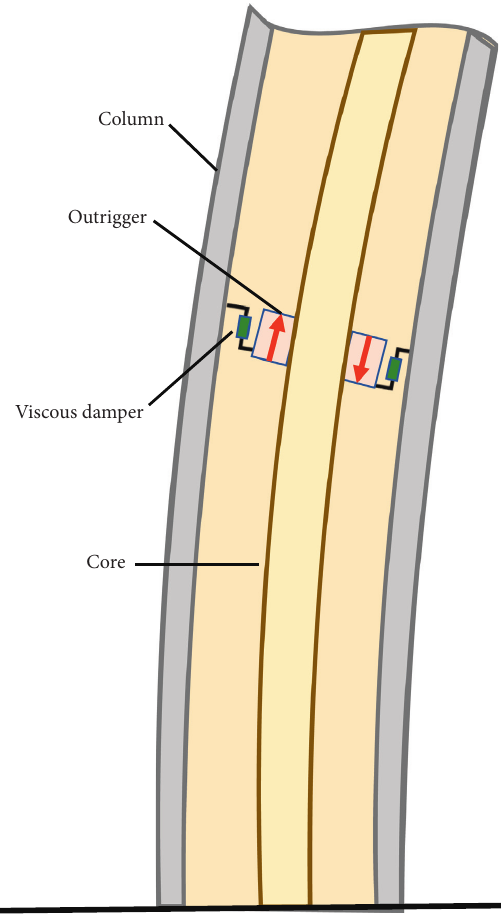
Figure 2: Damper connection mode of the damped